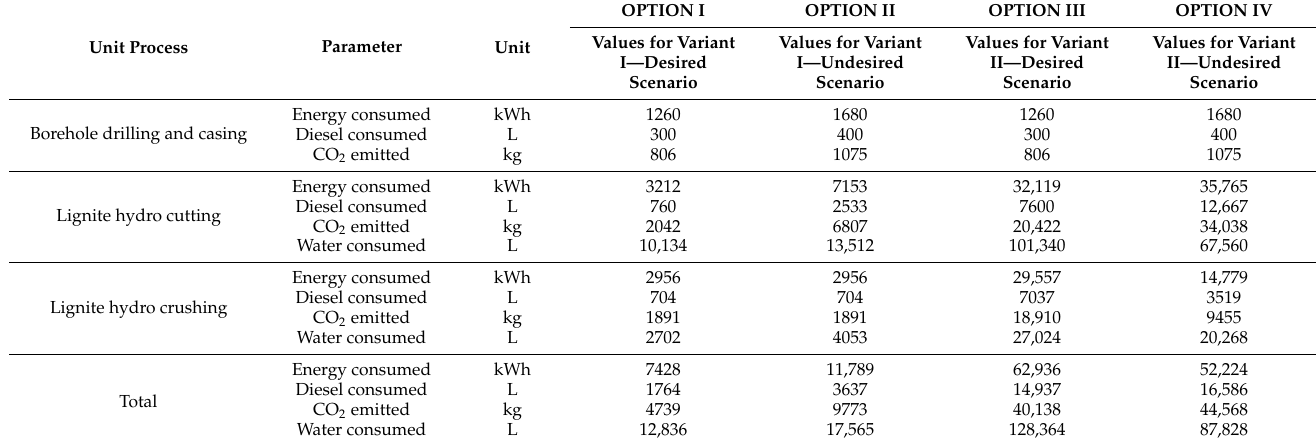
Table 4. The characteristics of the four options of the HBM lignite production